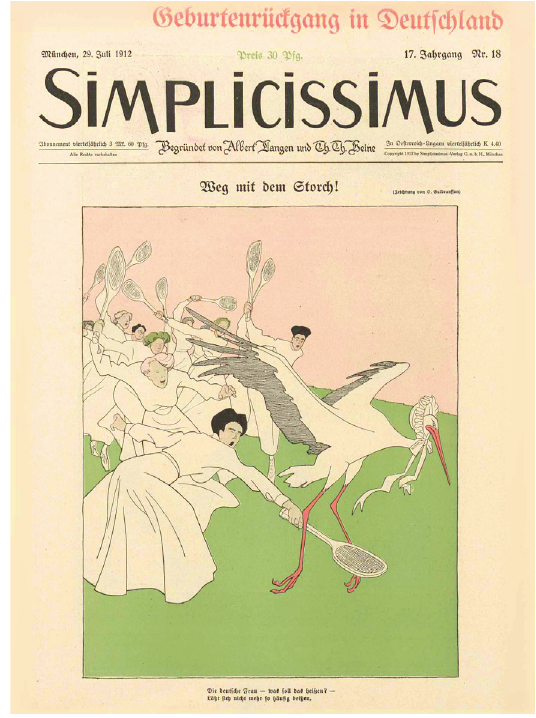
Figure 2. Cover of the satirical magazine Simplicissimus , July 1912. Heading in red print: ‘The Decline of the birth rate in Germany’. Image courtesy of Herzogin Anna Amalia Bibliothek Weimar. © DACS